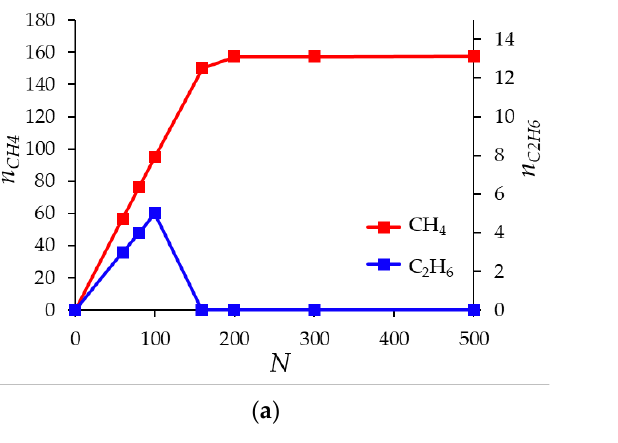
Figure 11. Instantaneous snapshot of the molecular dynamics trajectory of a simulation system consisting of two graphenes at a distance of H S = 1.0 nm ( a ) and 1.8 nm ( b , c ) at different numbers of N molecules (the ratio of the number of molecules of methane and ethane is 95:5) in simulation cell: 160 ( a ); 100 ( b ); 1000 ( c ). The bonds of atoms forming graphene are indicated by solid lines. Atoms are shown as unscalable red (methane) and blue (ethane) spheres.